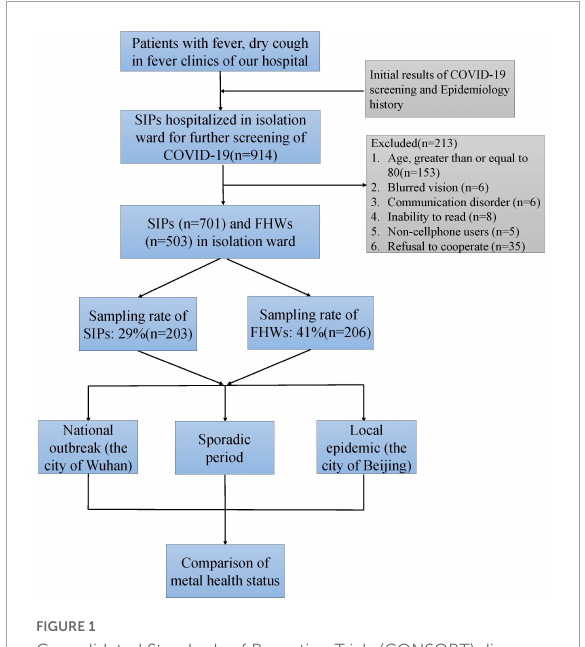
FIGURE1 Consolidated Standards of Reporting Trials (CONSORT) diagram of the study. COVID-19 , coronavirus disease 2019; FHWs , frontline health care workers; SIPs , suspected infected patients.